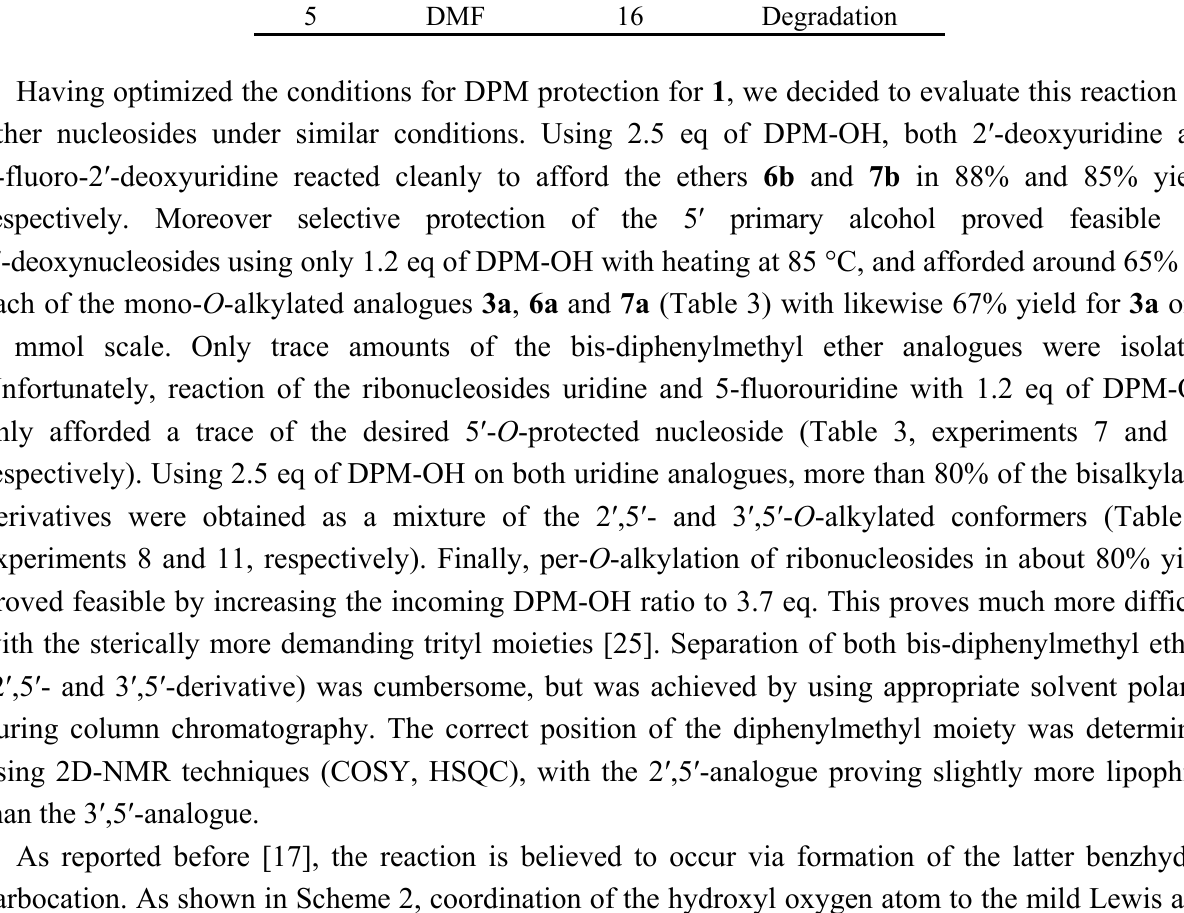
Table 2. Solvent influence on DPM ether formation at either 85 °C or boiling temperature. Entry Solvent Time (h) Yield 3b (%) 1 DCE 16 87 2 Acetonitrile 48 47 3 THF 48 42 4 Dioxane 16 Degradation 5 DMF 16